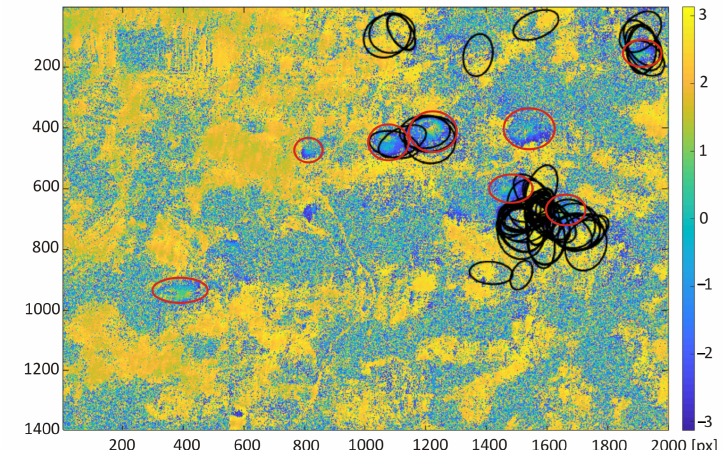
Figure 15. Interferogram of the second area computed from pictures recorded by Sentinel-1 on the 10th and 22nd of October 2016. Red ellipses are the subsidence area marked by experts; black ellipses were detected by Hough transform.